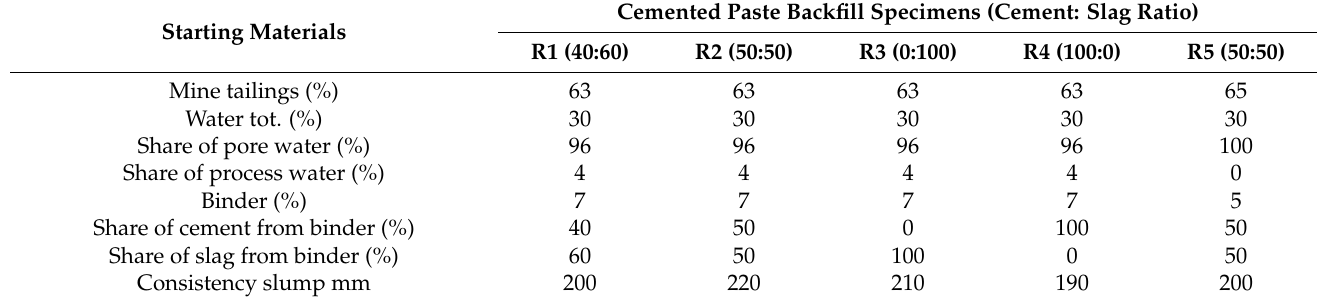
Table 1. The percentages of used materials for the five studied recipes